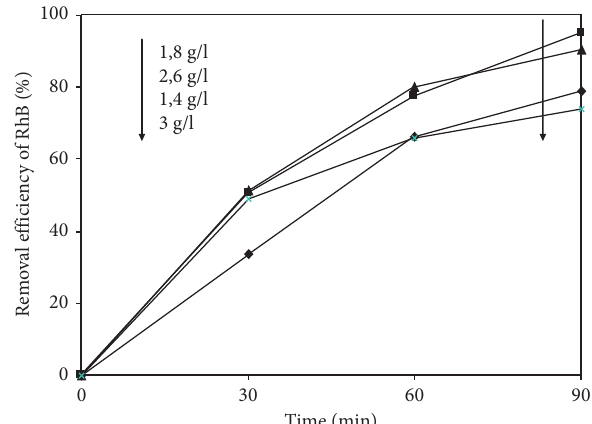
2 under different